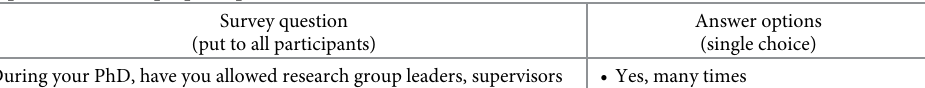
Table 3. Survey questions and answer options probing the first two research questions. Research question 1: How many European PhD students believe they have granted guest authorships to their supervisor or other people in